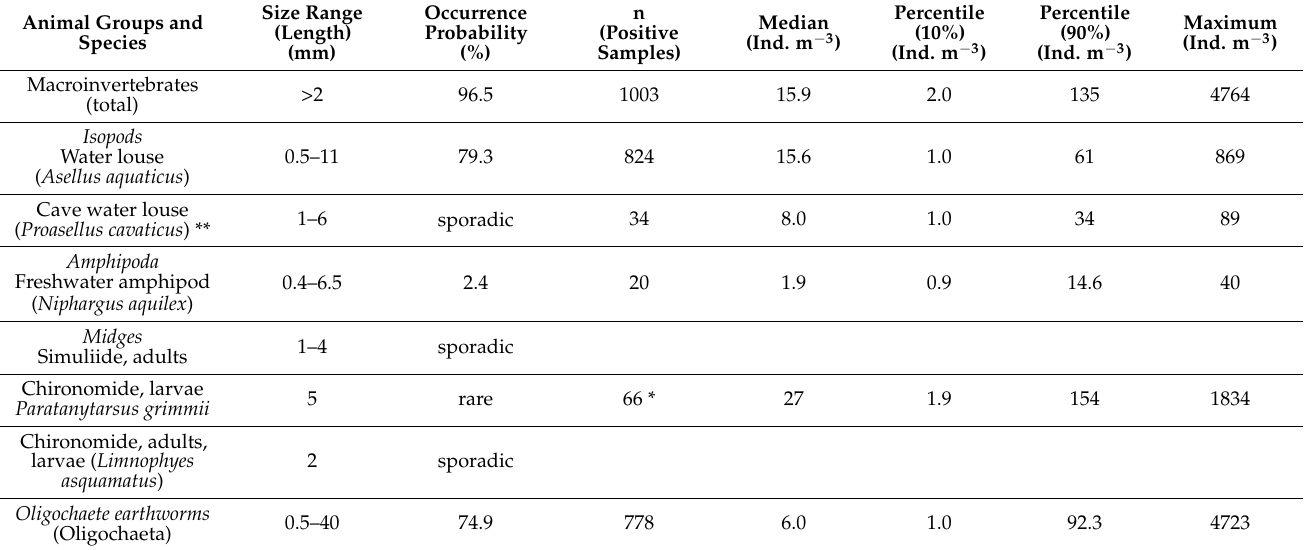
Table 1. Size range and occurrence of macroinvertebrates in drinking water networks in the European lowlands. Data base = 1039 hydrant samplings with 100 µ m